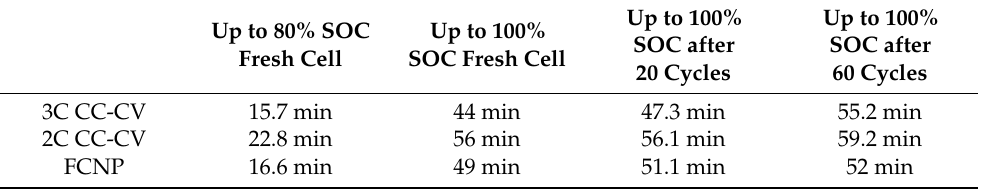
Table 4. A Comparison between the negative pulsed charging current and CC-CV protocol.